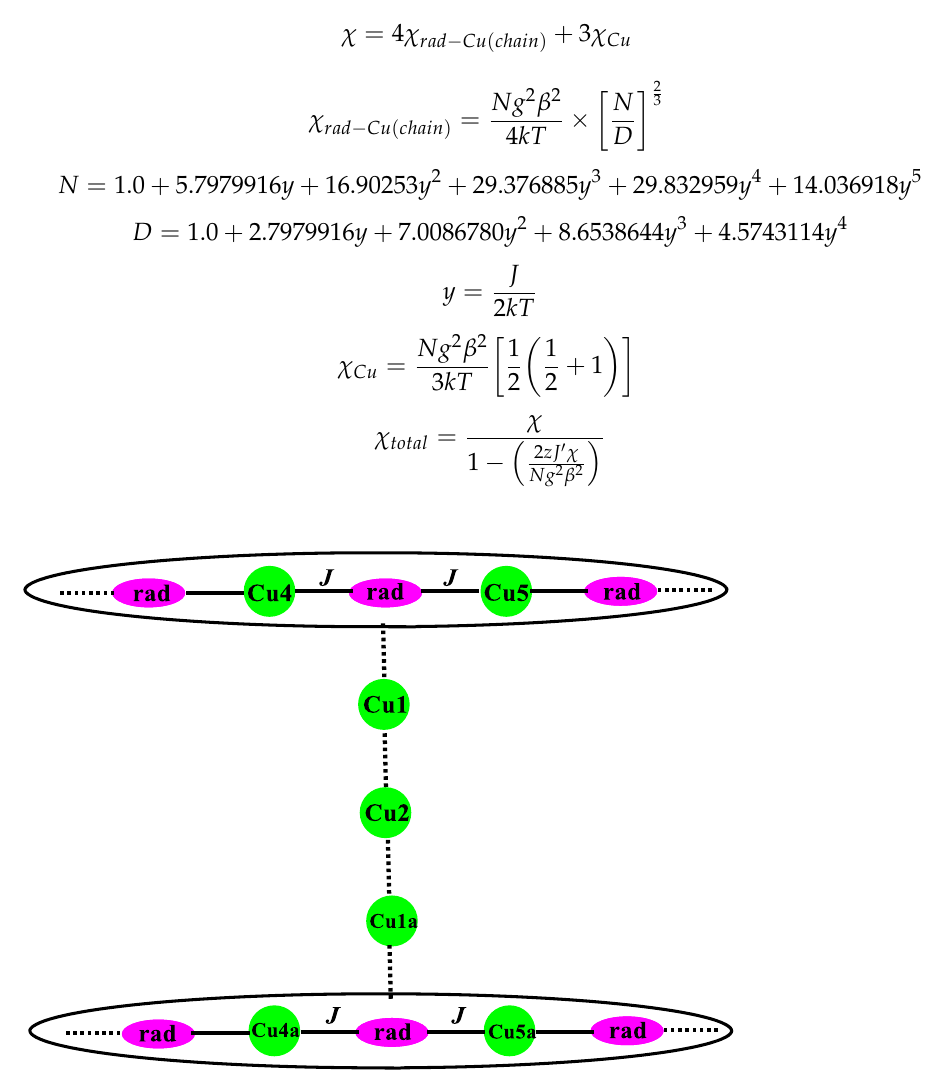
Figure 6. ( left ) χ M T versus T chart of the reticular complex in 2 (the crimson curve denotes the fitting result). ( right ) M versus H chart at 2 K (the blue curve denotes the sum of the Brillouin function).